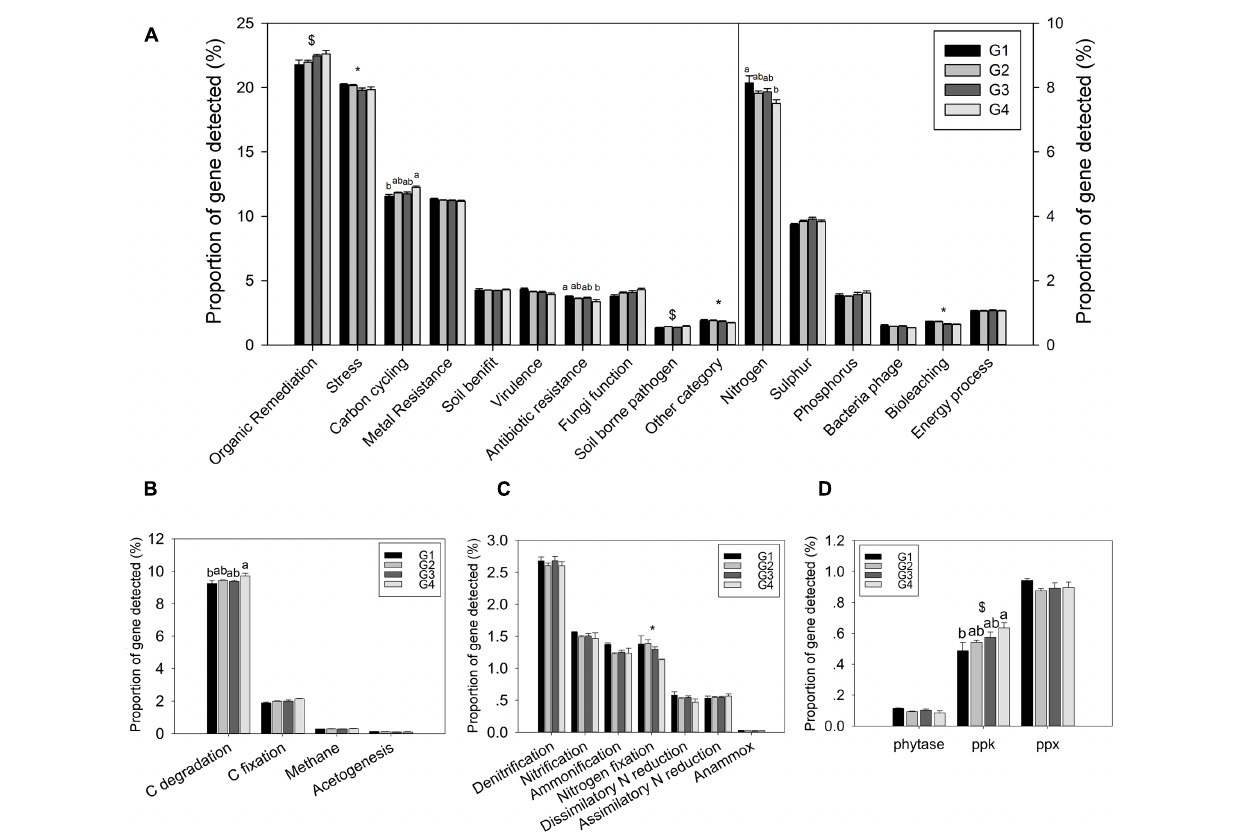
FIGURE 2 | Proportions of genes in different functional categories. (A) All functional gene categories, (B) C-cycling subcategories, (C) N-cycling subcategories, and (D) P-cycling subcategories. All data are shown as mean ± standard deviation of the proportions of each gene category, or each subcategory, of microarray probes detected in each group of samples in the ECS. Significant differences among/between those groups, and between surface and bottom water samples indicated by ANOVA with Tukey’s post hoc test are indicated by letters a and b, and by ∗ and $, separately, above the bars. The different letters indicate P < 0.05. ∗ Indicates higher mean proportion in surface samples, while $ indicates higher mean proportion in bottom samples with P <